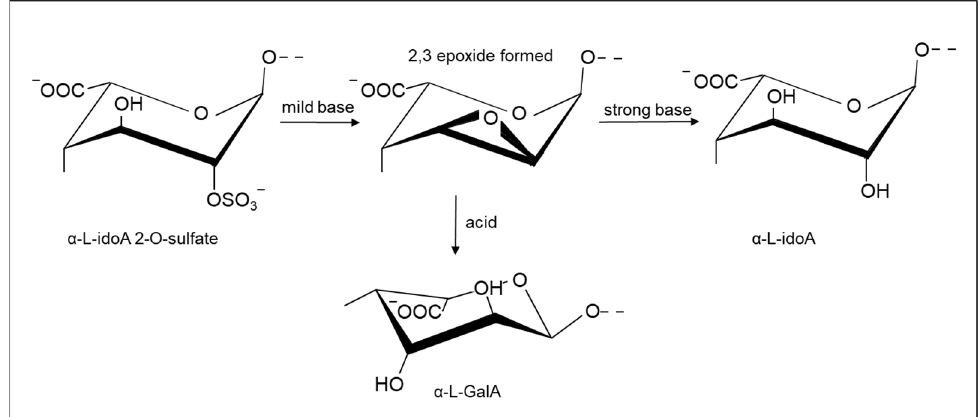
Figure 3. Reactions of 2- O -sulfated L-IdoA 2-sulfate in heparin and heparan sulfate under basic conditions and subsequent opening in acid or base. Treatment in strong base creates de- O -sulfated α L-iduronate residues, while treatment in acid generates α L-galacturonate residues involving inversion of the stereochemistry at positions 2 and